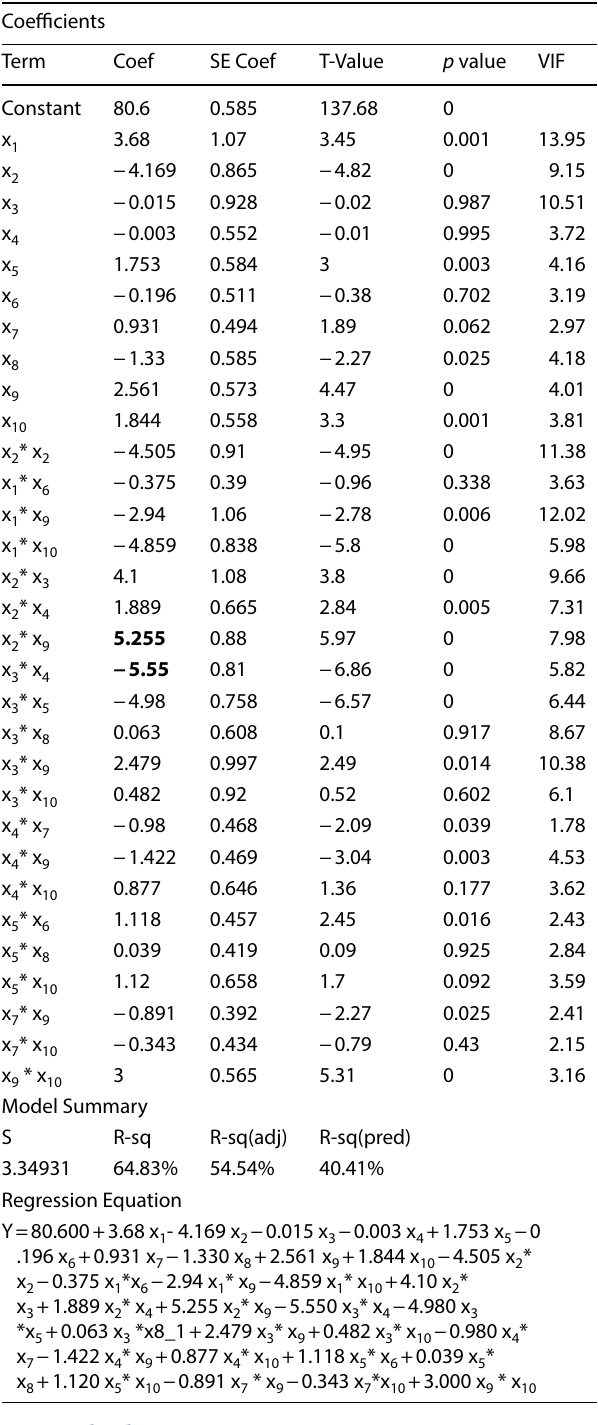
Table 13 Results of the stepwise algorithm on the second interval Coefficients